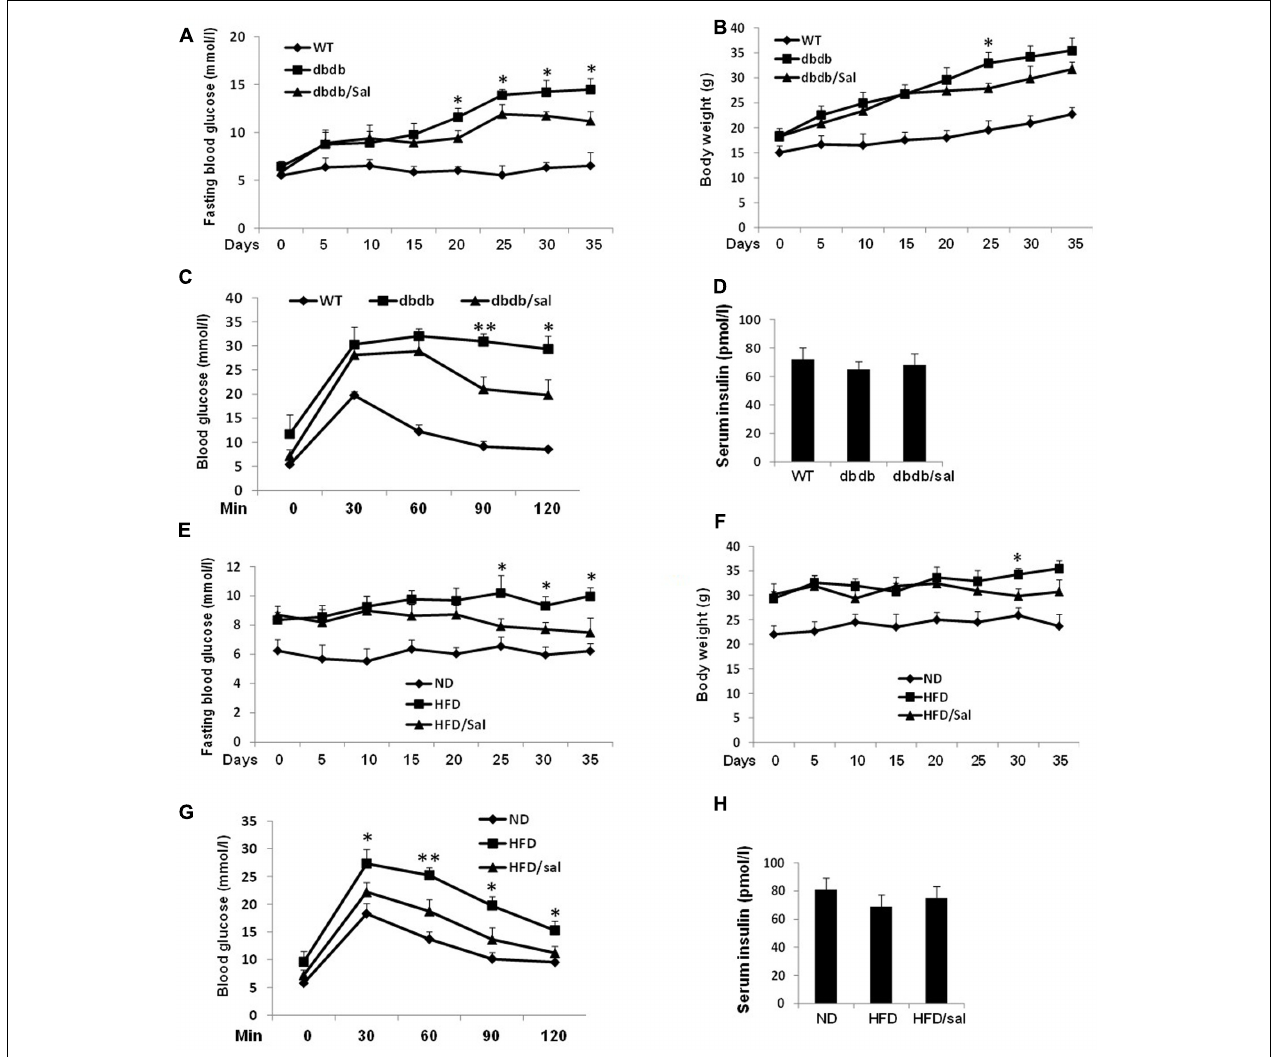
FIGURE 1 | Salidroside improved glucose homeostasis in db/db and HFD mice. (A,B) Effects of salidroside (100 mg/kg/day) on the fasting glucose levels and body weights in db/db group mice. (C) After 5-week treatment, OGTT was performed in wild type (WT), salidroside, or vehicle-treated db/db mice. (D) Serum insulin levels of mice from three groups after 5-week treatment of salidroside. (E,F) Effects of salidroside on the fasting glucose levels and body weights in HFD group mice. (G) After 5-week salidroside treatment, OGTT was performed in normal diet (ND), salidroside, or vehicle-treated HFD mice. (H) Serum insulin levels of mice from three groups after 5-week treatment of salidroside ( ∗ p < 0.05, ∗∗ p < 0.01 dbdb to dbdb/sal or HFD to HFD/sal). Data are shown as mean ± SE, n = 8.